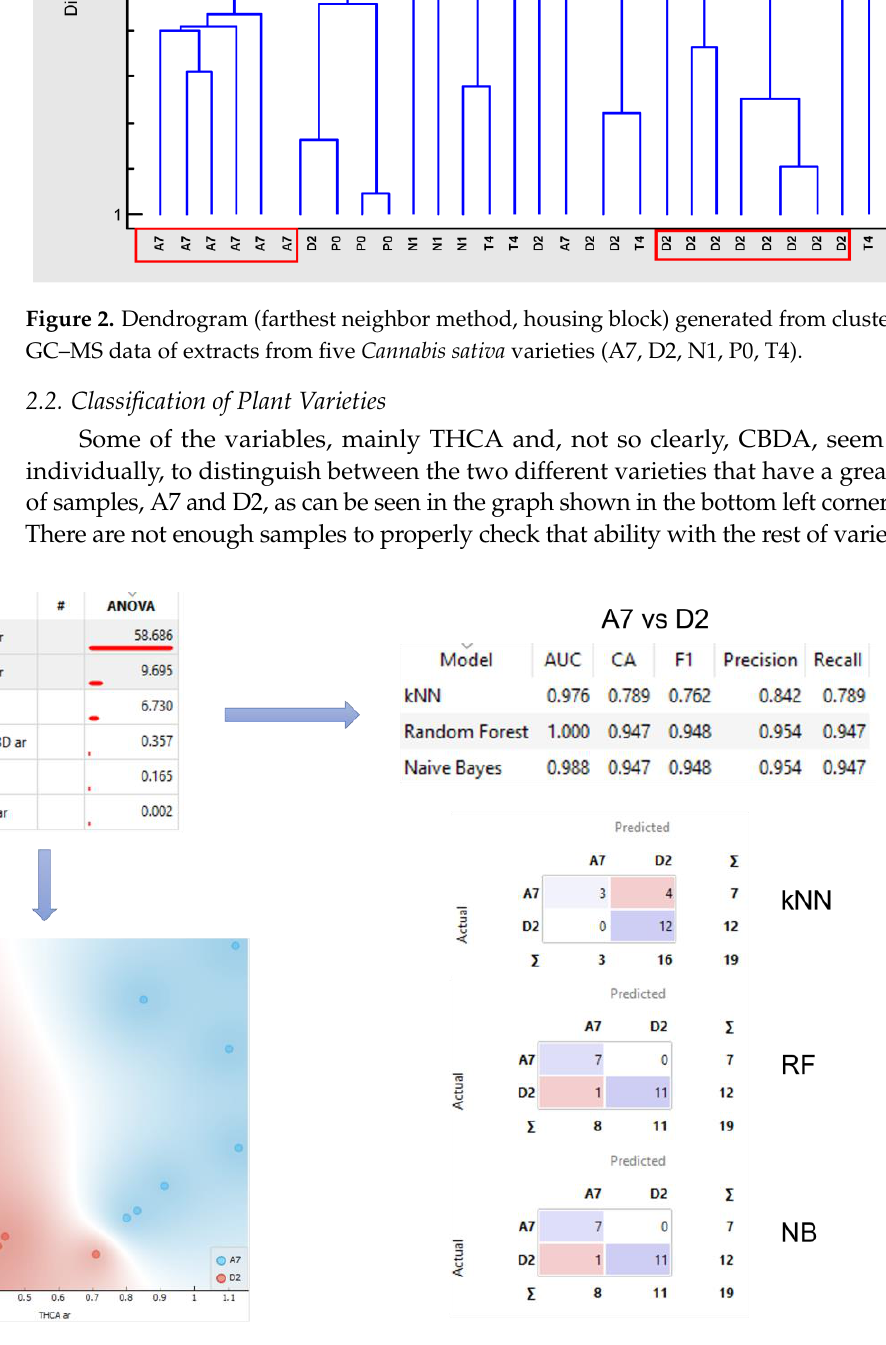
Figure 3. Analysis workflow. Sample separation for selected variables and confusion matrices for kNN, RF, and NB